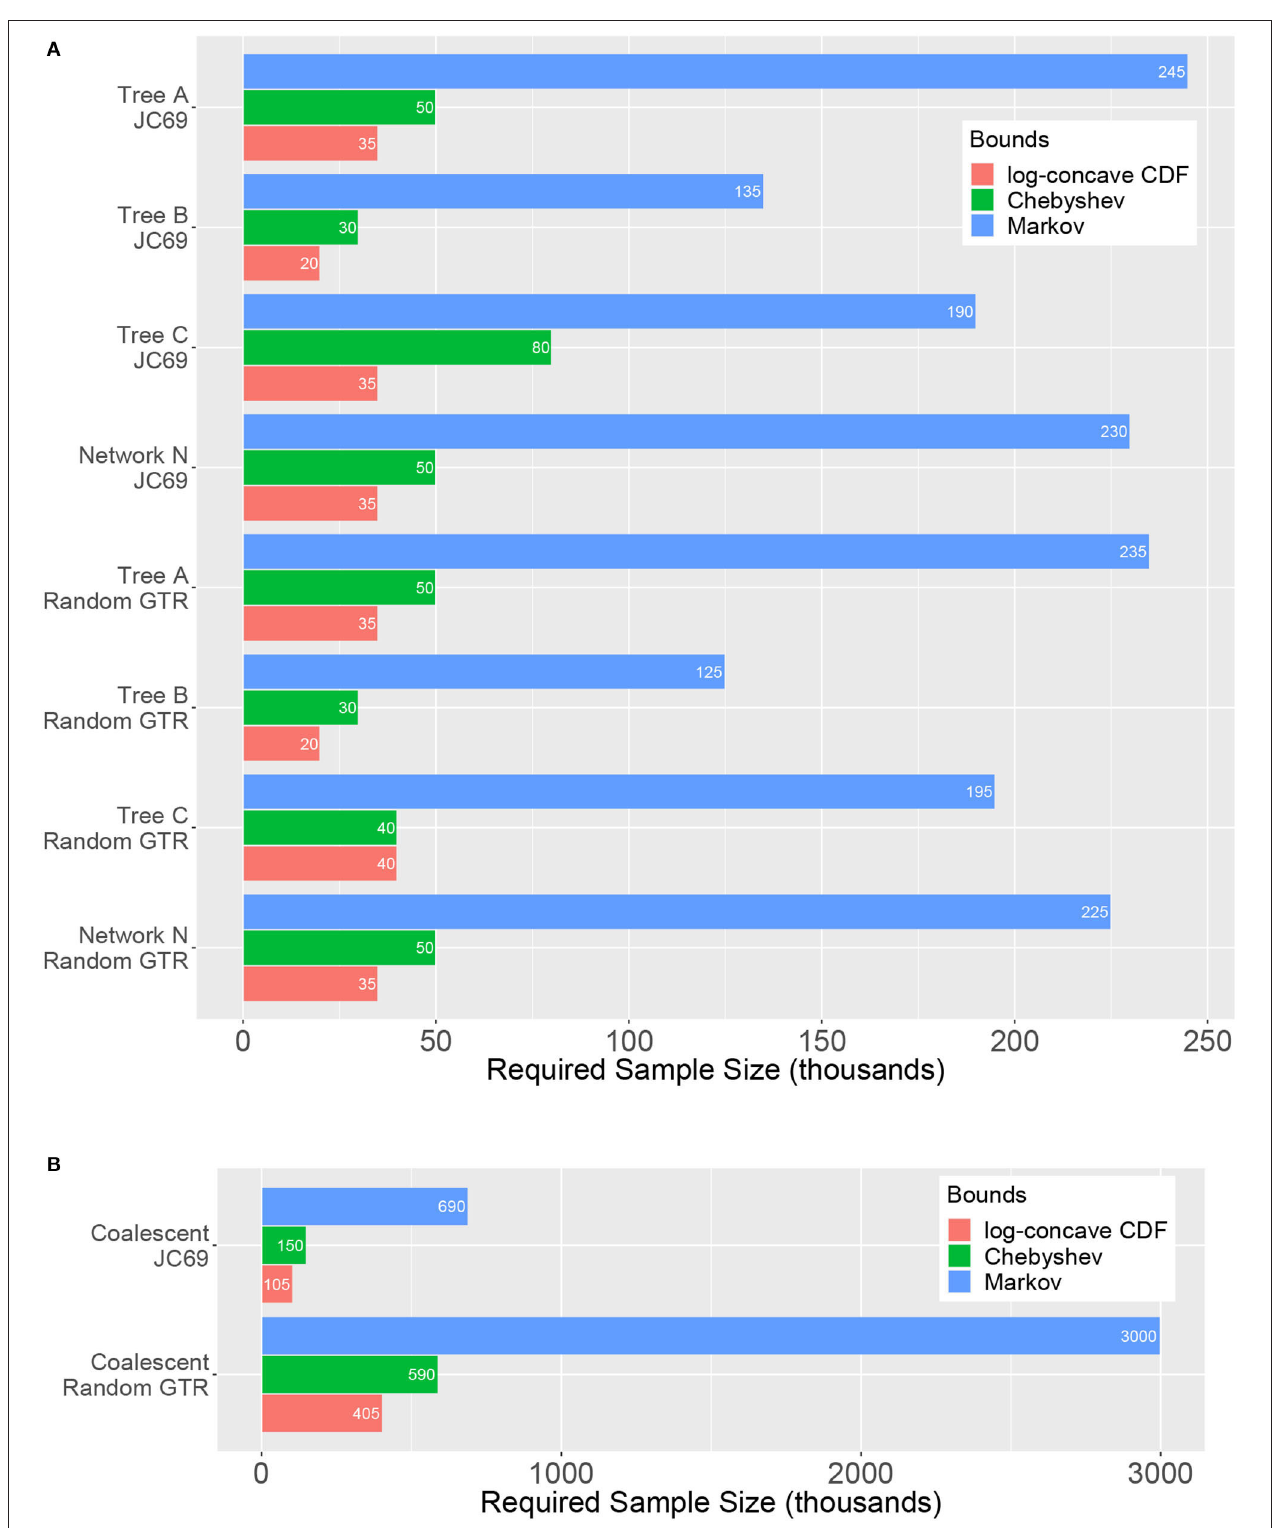
FIGURE 5 | Sample sizes required to achieve 95% power ( x -axis, in thousands) for various trees and models ( y -axis) for the hypothesis tests based on the Markov, q )) 2 ; (B) Coalescent simulations using ( S T 2 10 ( q )) 2 . Lengths of the bars correspond to the Chebyshev, and log-concave CDF bounds. (A) Gene tree simulations using ( S T 2 4 ( ˆ ˆ required sample size, and thus shorter bars indicate a more powerful test. The test based on the log-concave CDF bound is clearly the most powerful across the range of conditions explored. The test based on the BHC bound is omitted because it often required sample sizes in excess of 2 million sites to achieve 95% power.